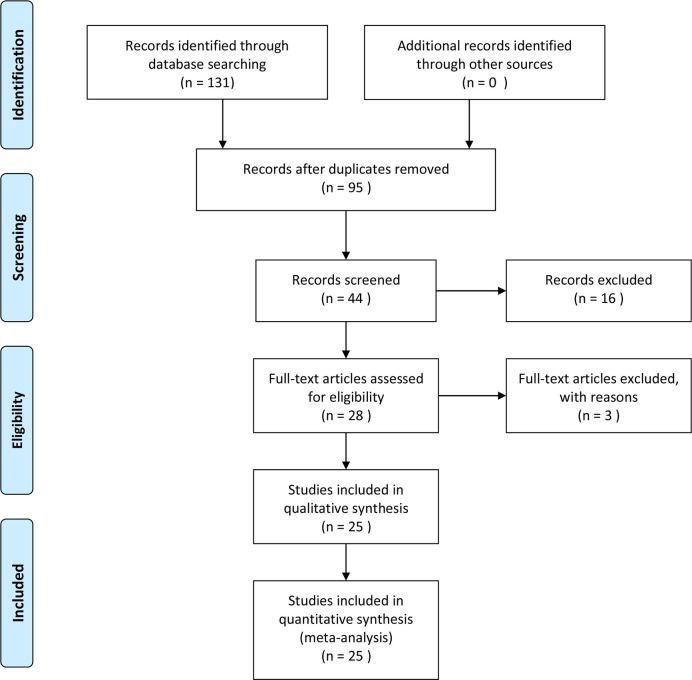
Flowchart of the search protocol for eligible studies.